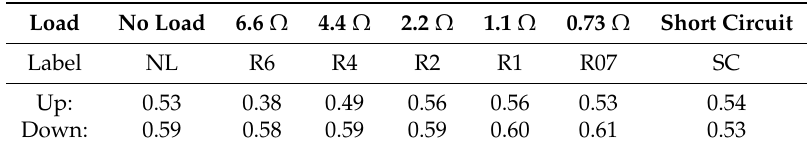
Table 3. Top speed in m/s during full stator overlap for different loads. The labels are used in Figures 7, 12, 13 and 14.